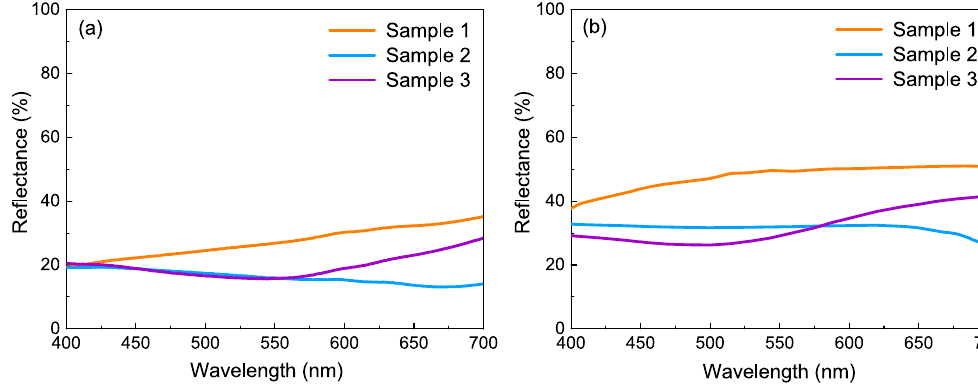
Figure 2. Optical reflectance property measured with incident angles of: ( a ) 30°, ( b ) 70°.